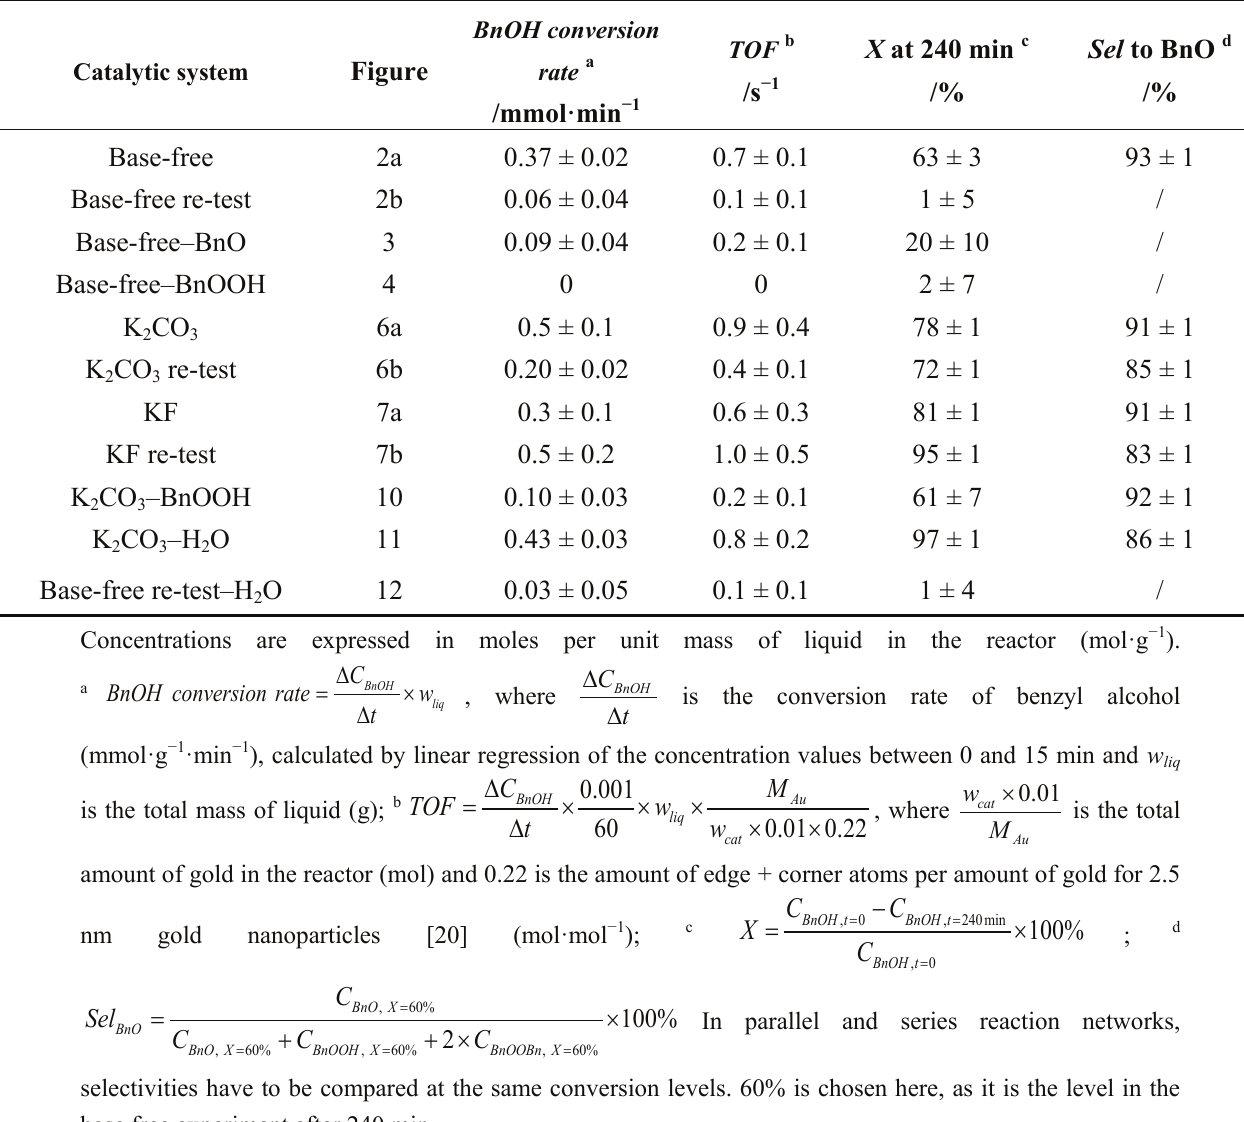
Table 1. Benzyl alcohol conversion rate, turn over frequency ( TOF ), conversion at 240 min and selectivity to benzaldehyde at 60% conversion for AUROlite™ catalyst in different test